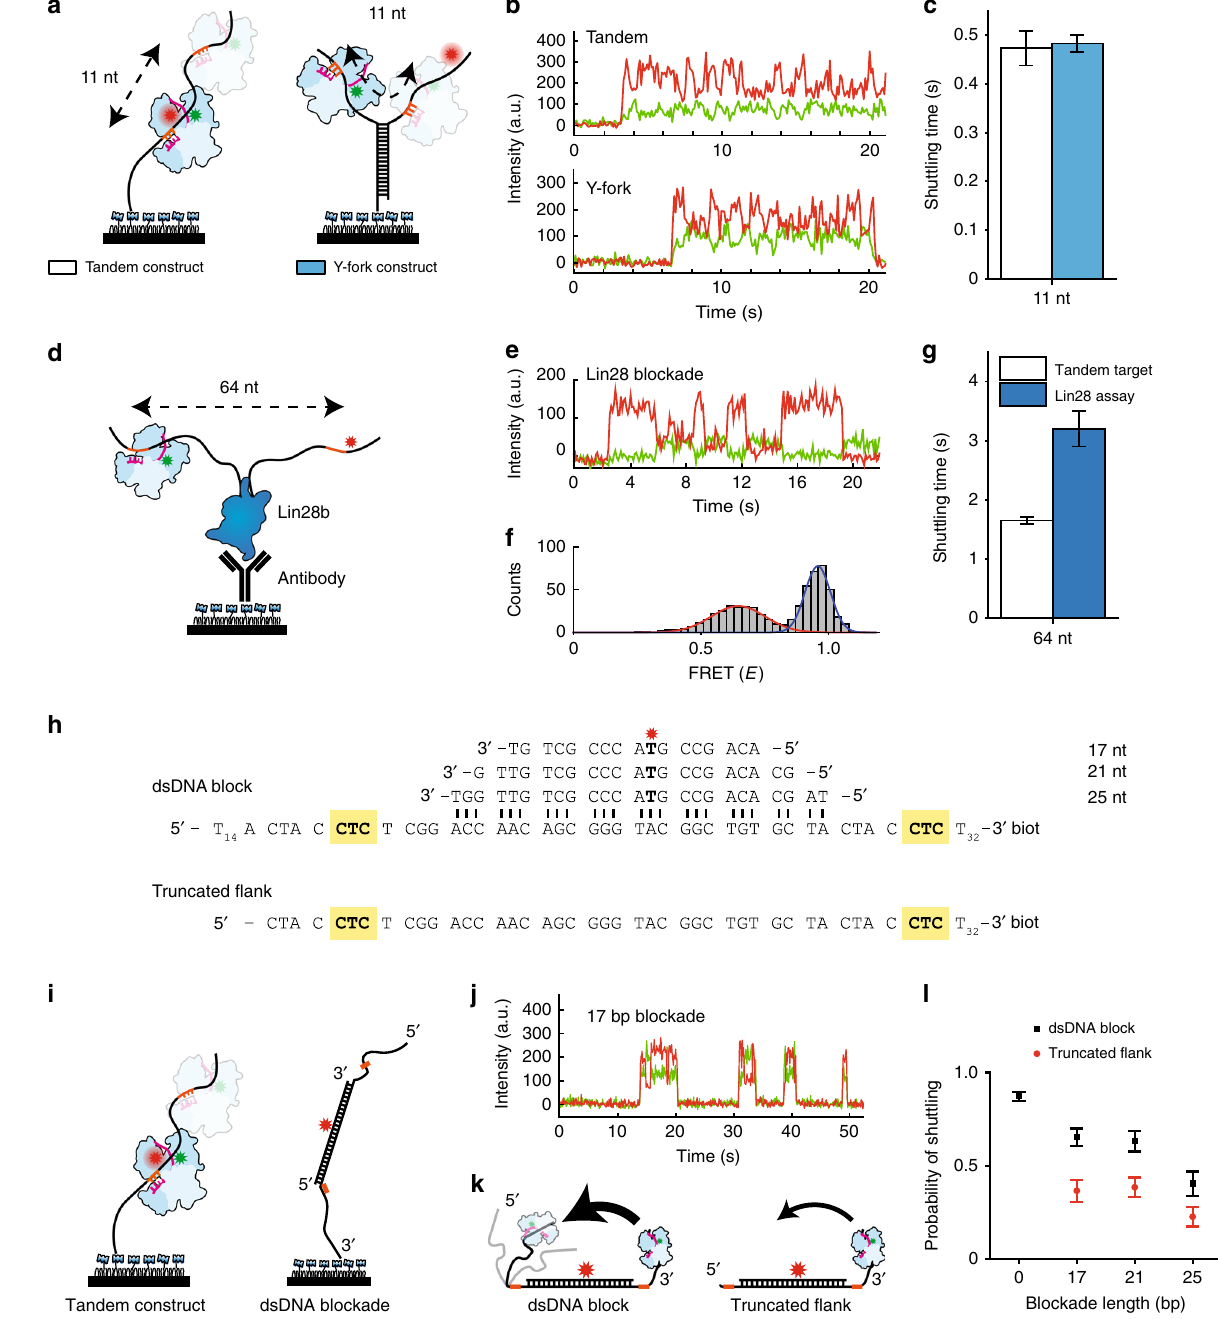
Fig. 5 Argonaute can overcome structural and protein barriers. a Schematic drawing of the tandem target assay (left) and the Y-fork assay (right) with 11 nt separation between targets. b Representative shuttling traces of the tandem target assay (top) and Y-fork assay. c , The shuttling time of the Y-fork junction (blue bar) compared with the tandem assay (white bar). The experimental data of both sets were taken on the same days. Error bars indicate the 95% con fi dence interval acquired from 10 5 bootstraps d , Schematic drawing of the His-Lin28b blockade assay, where targets are separated by 64 nt. Immobilization happens through a biotin-anti-His antibody. e Example of a shuttling trace with Lin28b located between two targets. Exposure time is 100 ms. f FRET histogram (molecules n = 46) fi t with two Gaussian functions ( E = 0.64 for red fi t and E = 0.95 for dark blue fi t). g The shuttling time of the Lin28 assay compared with the tandem target assay for 64 nt separation between targets. h Sequences used for the dsDNA block assay, indicating the base pairing between a 17, 21, and a 25 nt long blockade and the target strand. The dsDNA block construct has a 19 nt fl ank on the 5 ′ side, whereas the “ truncated fl ank ” has a 4 nt fl ank. i Schematic of a dsDNA block assay, where the CTC targets are highlighted with orange. j Representative trace of binding and shuttling of CbAgo on a 17 bp blockade DNA construct. k (left) Schematic of dsDNA block construct with full length fl anks. (right) schematic of the truncated version where the fl ank on the 5 ′ side is removed. The thickness of the arrows indicate the observed shuttling probability. l The probability of shuttling upon binding to a CTC target plotted vs. the blockade length (none, 17, 21, and 25 nt) for full length fl anks (black squares) and for the truncated fl anks (red circles). Error bars are given by the 95% con fi dence interval acquired from 10 5 bootstraps. Source data are provided as a Source Data fi